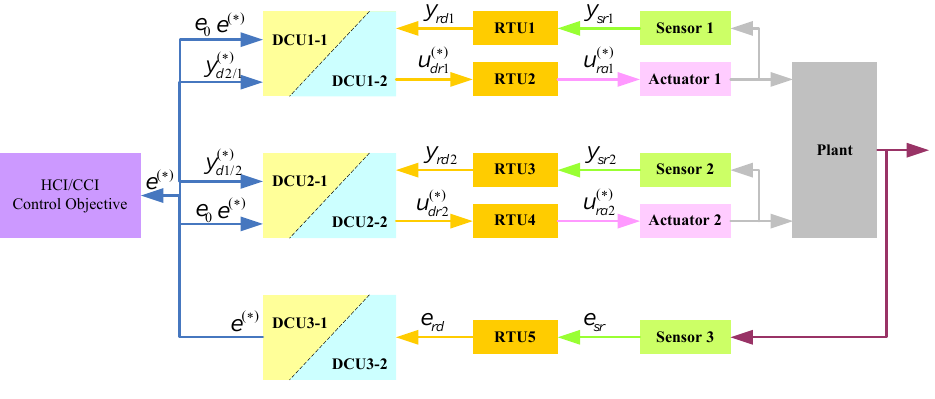
Figure 2. Cooperative control mode of